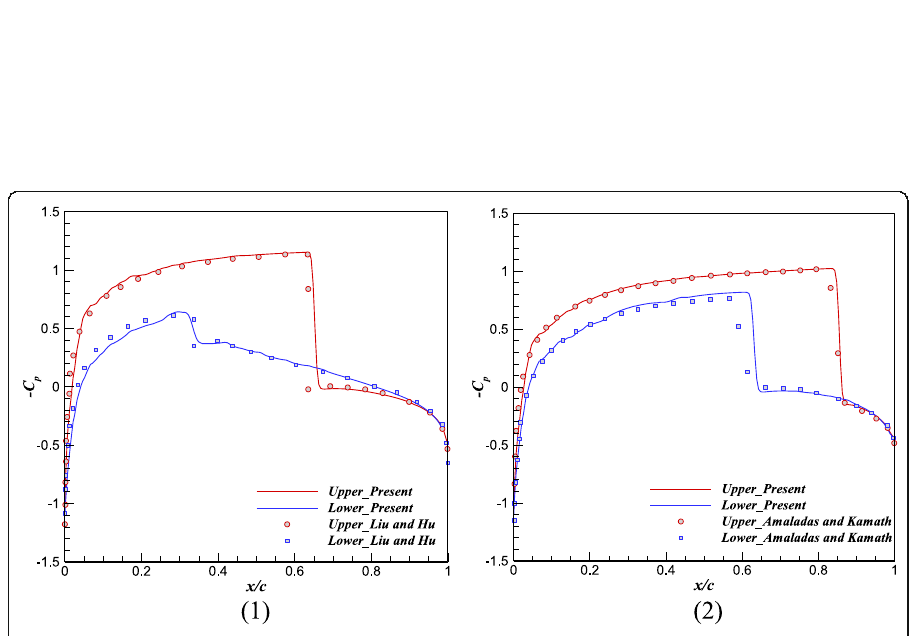
Fig. 6 Pressure coefficient on the upper and lower airfoil surfaces compared to reference results with different flows (1) Ma = 0.8, α = 1.25 ∘ and (2) Ma = 0.85, α = 1